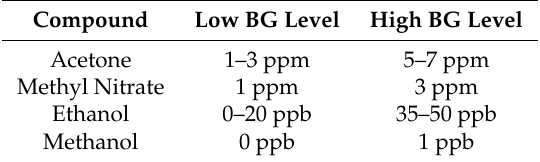
Table 1. VOC concentrations for low and high blood glucose levels